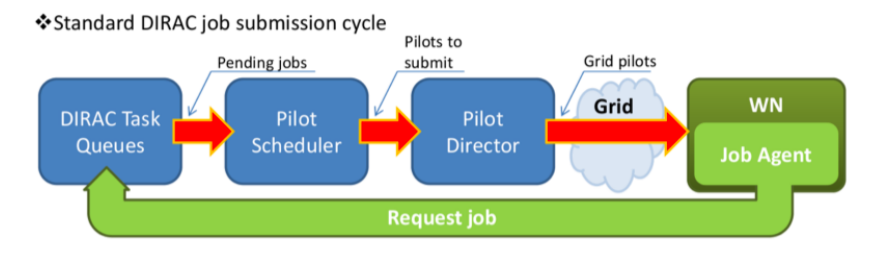
Figure 3. Standard DIRAC job submission